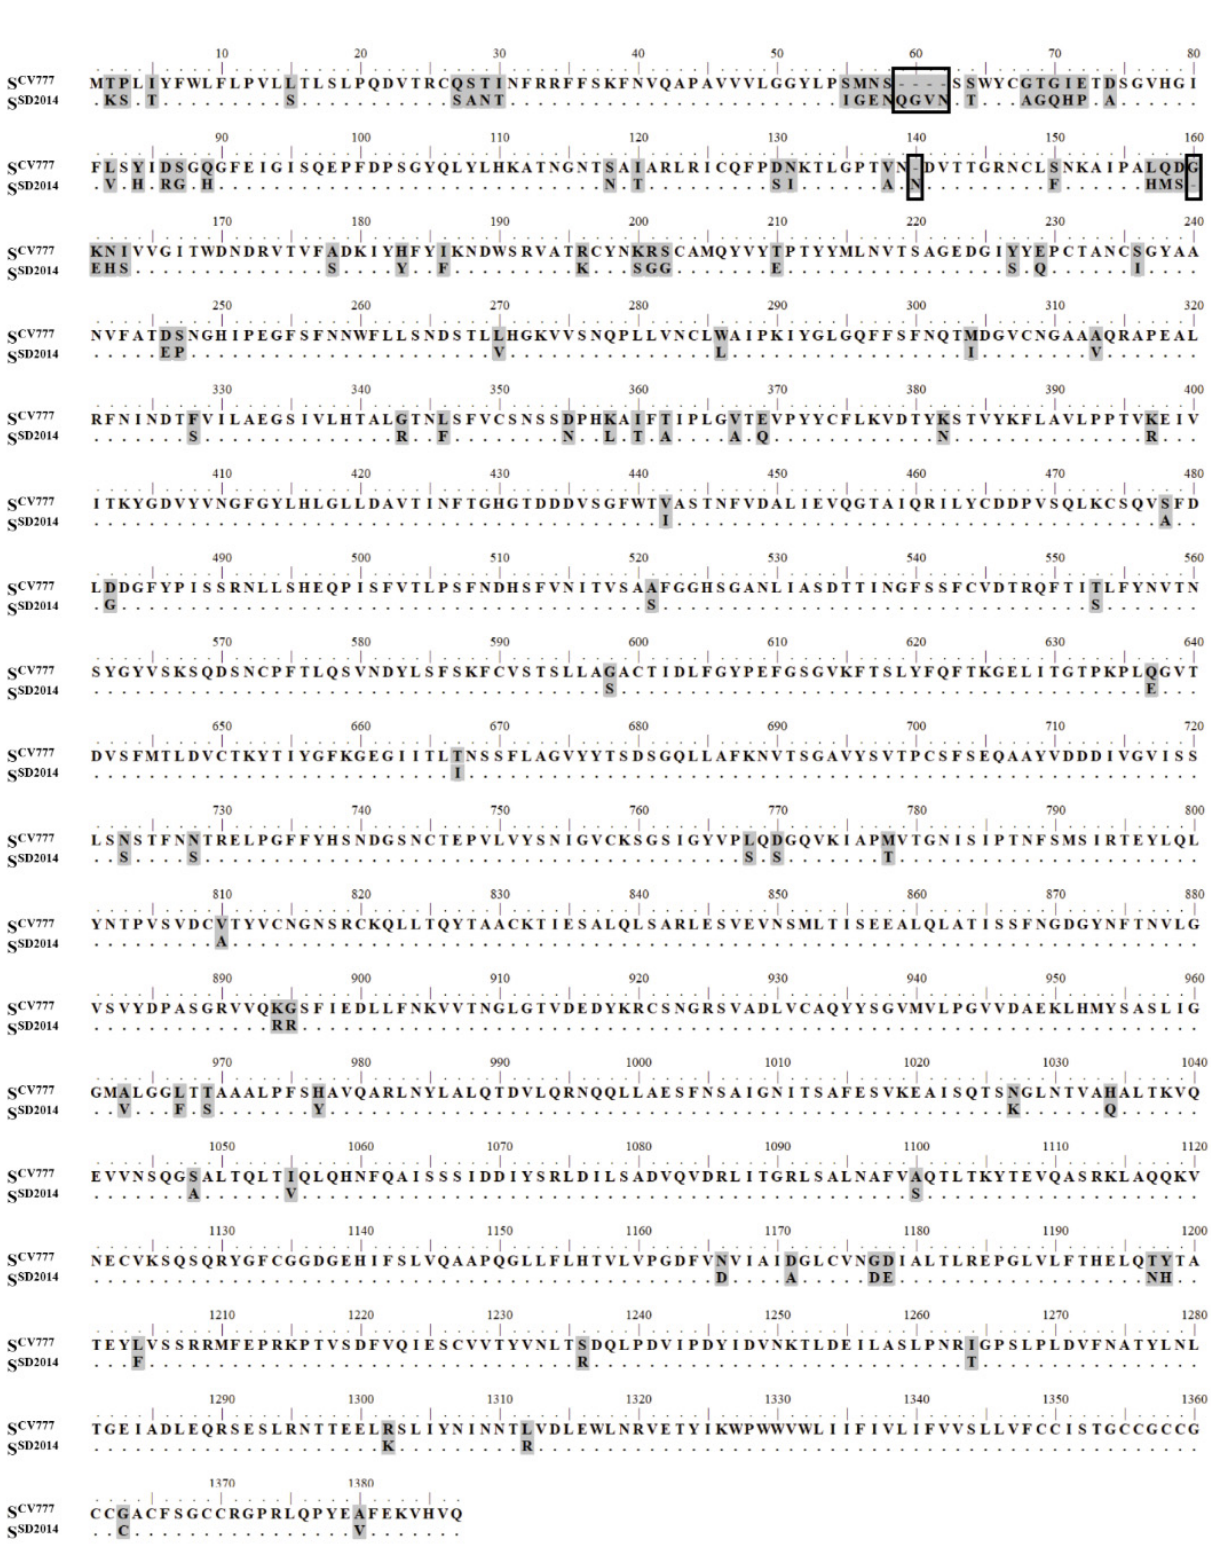
Figure 2. Amino acid sequence comparison of S CV777 and S protein of PEDV SD2014 (S SD2014 ). Amino acid sequences of S CV777 and S SD2014 (AND76936) were aligned with Mega 7. Differential amino acids were shaded with grey. The identical amino acid in the sequence of S SD2014 was substituted with a “.”; The amino acid in rectangle was the insertion/deletion site.